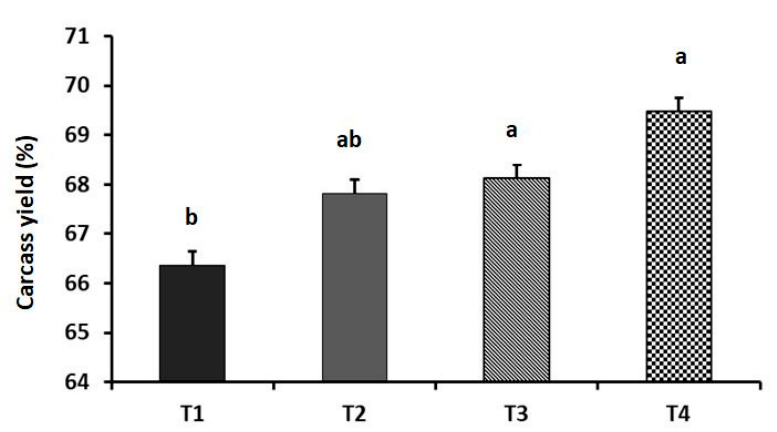
Figure 2. Effect of dietary supplementation of guanidinoacetic acid (GA) on the carcass yield of aged laying hens ( p = 0.039 and 0.590 as linear and quadratic, respectively). T 1 = control group; T 2 = group supplemented with 0.5 g GA kg − 1 diet; T 3 = group supplemented with 1 g GA kg − 1 diet; T 4 = group supplemented with 1.5 g GA kg − 1 diet. Means with different letters (a, b) significantly differ at p ˂ 0.05. n = 8 birds/group.